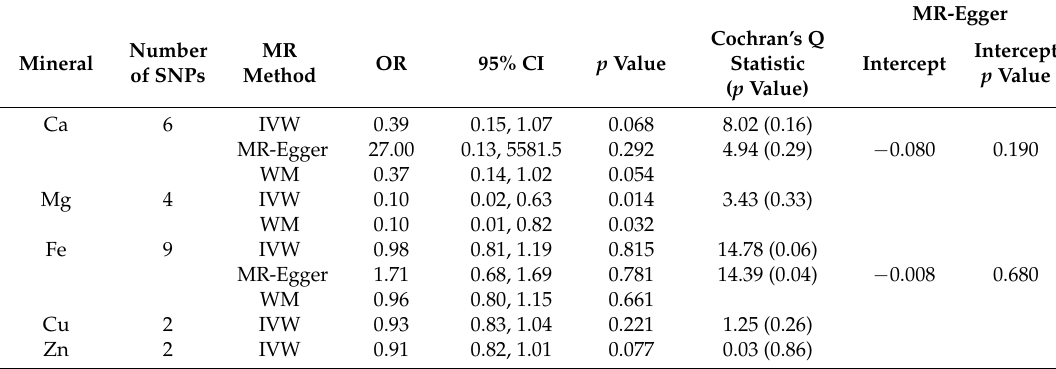
Table 3. MR estimates of the causality between five minerals and